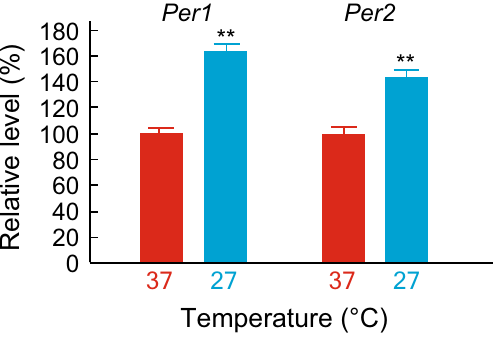
Figure 1. Effects of temperature on transcript levels of clock genes in Rat-1 fibroblasts. Relative mRNA level of Per1 or Per2 after 2-day culture at 37 °C or 27 °C . Mean with s.e.m. from 3 independent samples are shown. The expression levels at 37 °C were set to 100 in vertical axis. ** p < 0.01 compared to the data of 37 °C (Student’s